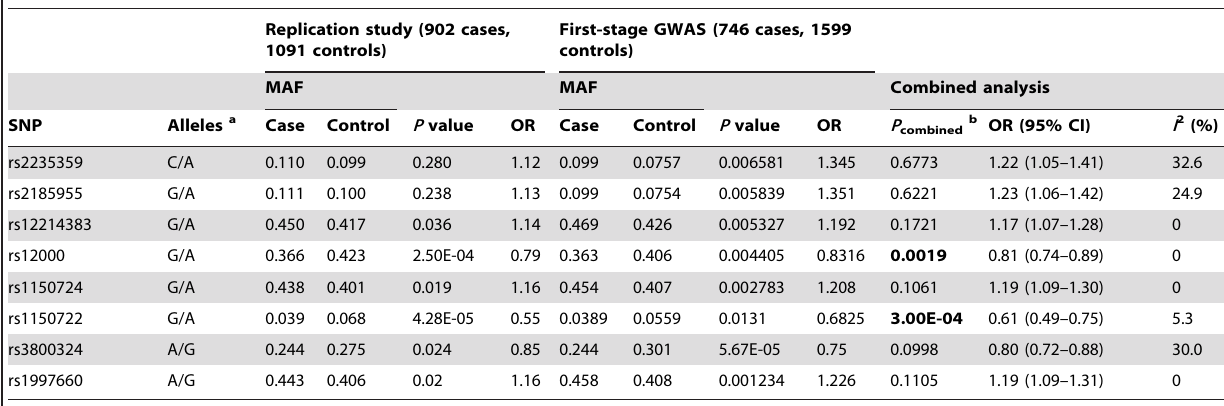
Table 3. Combined study of replication and first-stage GWAS samples.